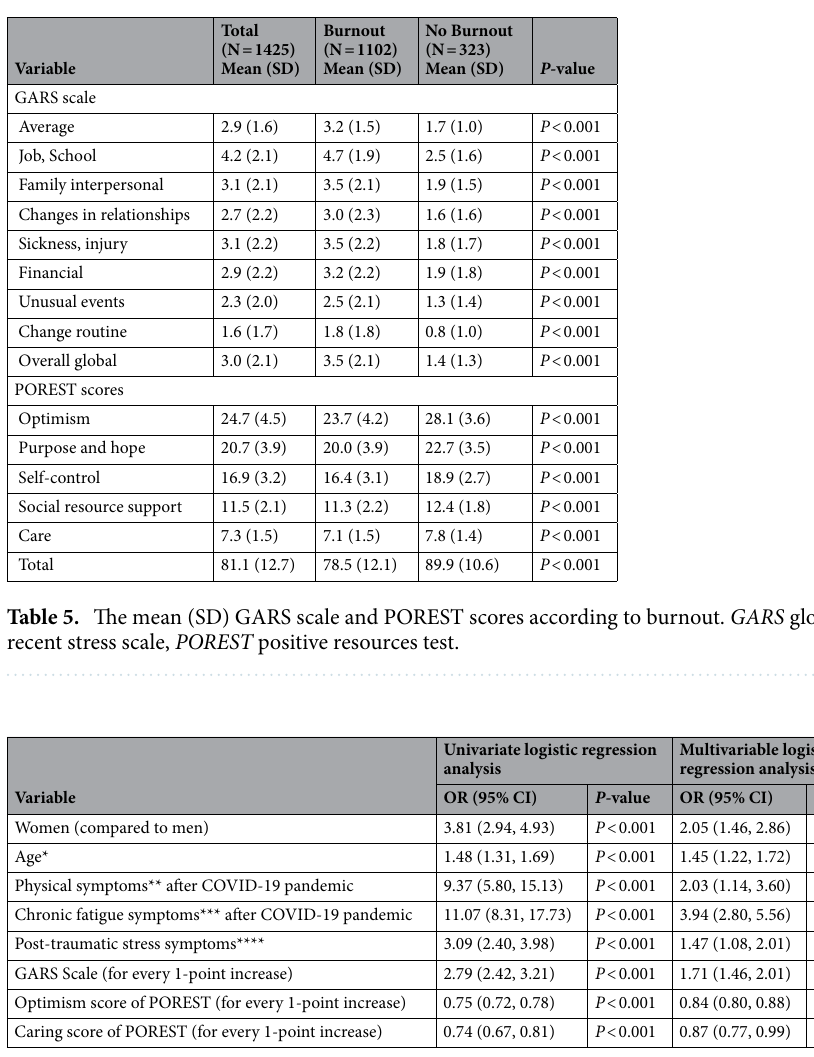
Table 6. Logistic regression to identify the correlates of burnout. CI confidence interval, GARS global assessment of recent stress scale, POREST positive resources test. *60 years and older, 50–59 years, 40–49 years, 30–39 years, 20–29 years, as the age group decreases from the older age group to the lower age group. **Physical symptoms mean a score of 10 or higher on the Patient Health Questionnaire-15. ***Chronic fatigue symptoms mean a score of 3.22 or higher on the Fatigue Severity Scale. ****Post-traumatic stress symptoms mean a score of 2 or higher on the Primary Care Post-Traumatic Stress Disorder-5